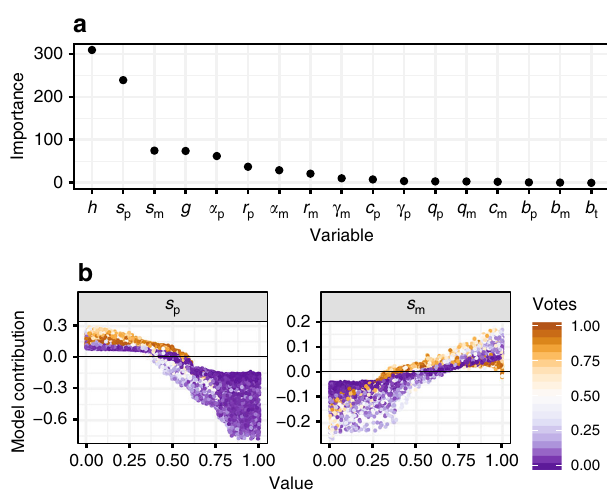
Fig. 6 Predictors of strong negative feedback according to random forest. Results from a random forest classi fi er using each variable to predict whether strong negative feedback develops. a Importance of each variable as a predictor of the development of strong negative PSF (true if I max < − 1.5, and false if I max > − 1.5). b Conditional feature contributions of mutualist and pathogen host af fi nity as predictors of whether strong negative feedback will develop. Point colour represents the proportion of decision trees that predict that strong negative feedback will develop. See Supplementary Fig. 3 for the conditional feature contributions of every